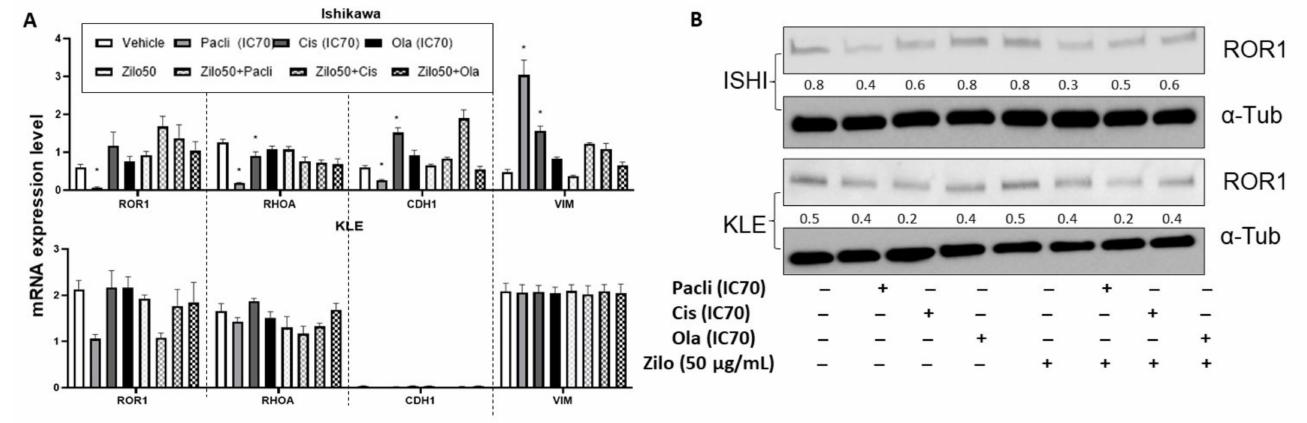
Figure 4. Real-time reverse transcription PCR and Western blot analysis following zilovertamab (“zilo”) +/ − Paclitaxel, Cisplatin, Olaparib treatment in endometrial cancer cell lines Ishikawa and KLE. ( A ). The relative mRNA level of ROR1, RHOA, CDH1 and VIM following the treatments indicated by the qRT-PCR result. * Significant at p < 0.05 compared with the vehicle. ( B ). Protein level of ROR1 following the treatments indicated by Western blot. The numbers below each lane represent ratios of band intensity of protein versus α -Tubulin calculated with ImageJ [16].